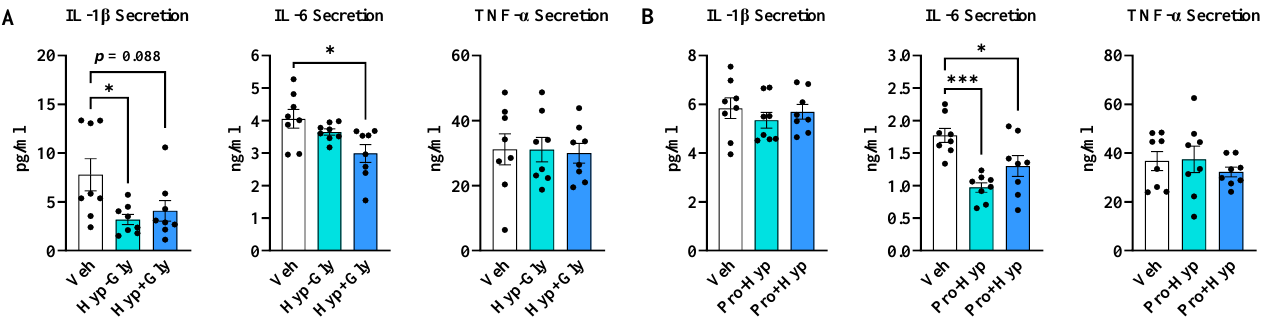
Figure 2. ( A , B ) The comparison of the effects of dipeptides and amino acids (each at 100 µM) on inflammatory cytokine secretion by M1 macrophages ( n = 8). Data are shown as means ± SE. Data were analyzed by one- way ANOVA followed by Tukey’s post hoc test [* p < 0.05, *** p < 0.001]. Hyp- Gly and Pro-Hyp refer to dipeptides. Hyp + Gly means a mixture of Hyp and Gly. Pro + Hyp means a mixture of Pro and Hyp.